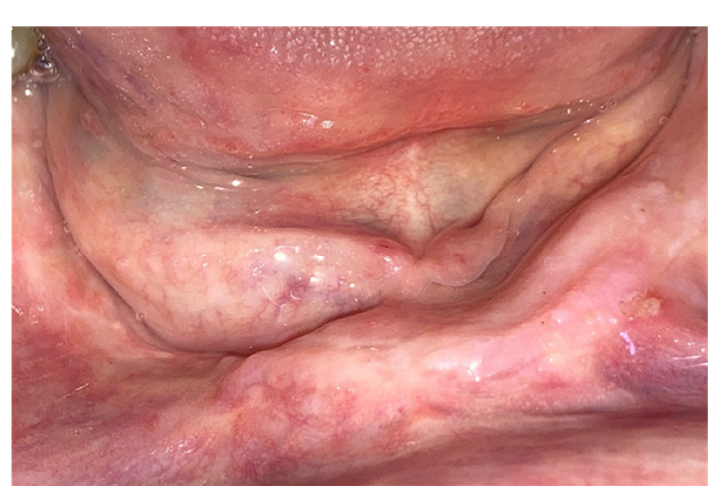
Figure 6. Primary healing.